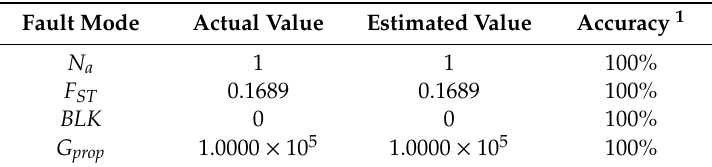
Table 2. Fault detection and isolation (FDI) results for nominal condition.